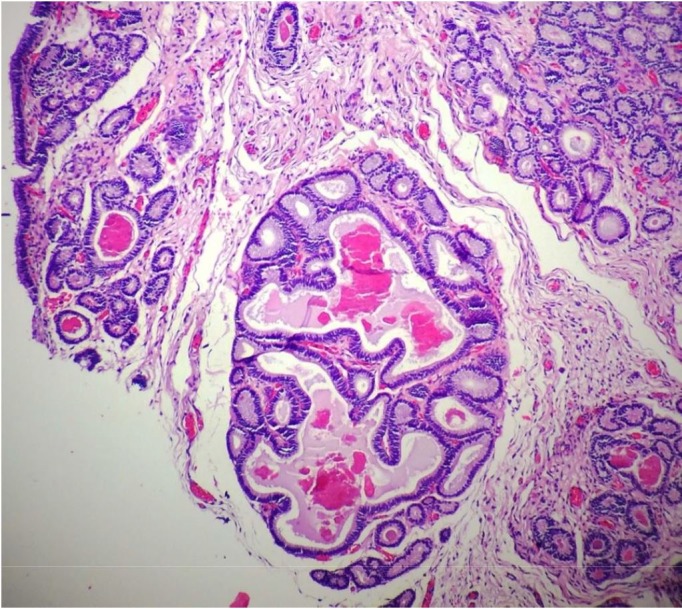
Gynecological examination in Pantaneiro mares. Endometrial biopsy in mare 4 shows moderate proliferation of the fibrous conjunctive tissue, the formation of a glandular island, and glandular dilation. Hematoxylin-eosin, 10×.